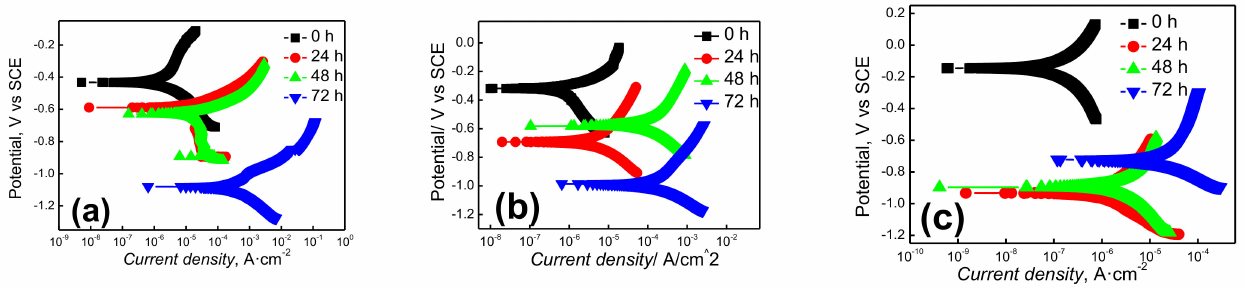
Figure 3. Polarization curves of electrodes at different corrosion time: ( a ) for specimens #1; ( b ) for specimens #2; ( c ) for specimens #3.